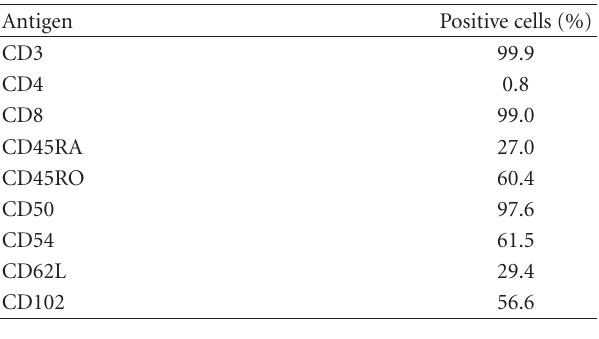
Table 1: Flow cytometric analysis of cell surface markers of FSP11- specific T cells. Expression of several cell surface markers of the FSP- specific T cell bulk culture was analyzed on day 91 of culture by FACS. Given is the percentage of positive cells. The corresponding isotype controls were always under 2.5%.